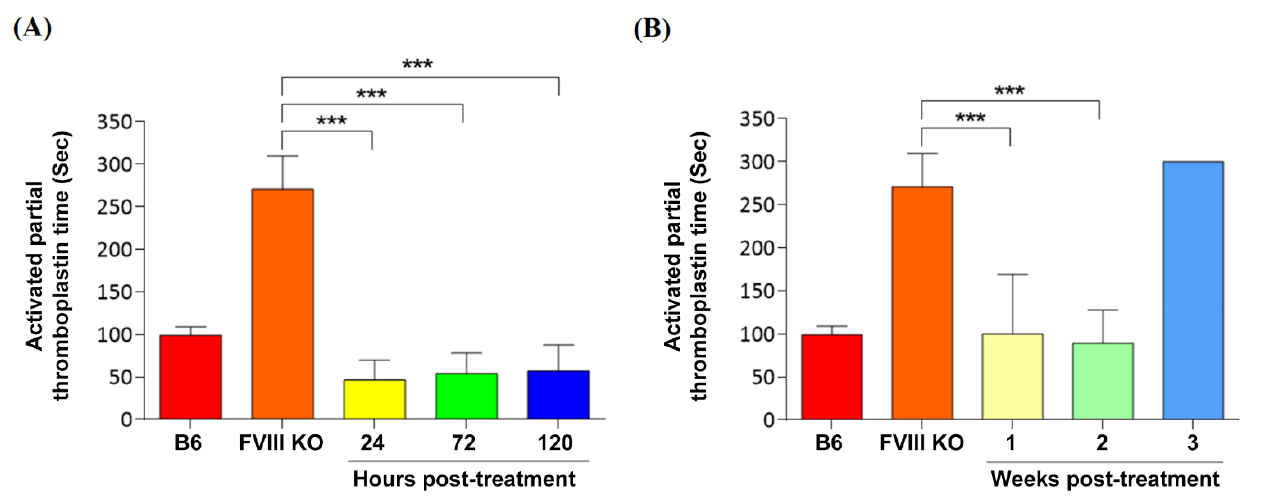
Figure 5. Assessment of coagulation restoration after DPPC-Fe 3 O 4 -PmAlb- BDD-FVIII gene therapy in mice with hemophilia A. ( A ) The aPTT test was performed at 24 h ( n = 3), 72 h ( n = 3), and 120 h ( n = 4) after intravenous injection with the DPPC-Fe 3 O 4 -plasmid complex to evaluate the short-term therapeutic effect. Untreated FVIII knockout mice ( n = 6) were used as a control for the disease group, and age-paired male C57BL/6J mice (n = 6) were used as a normal control group. ( B ) aPTT was tested weekly after intravenous injection with the DPPC-Fe 3 O 4 -plasmid complex to evaluate the long-term therapeutic effect. Data are presented as the mean ± SD, *** p < 0.001 vs. the untreated FVIII knockout mouse group (two-tailed t test).